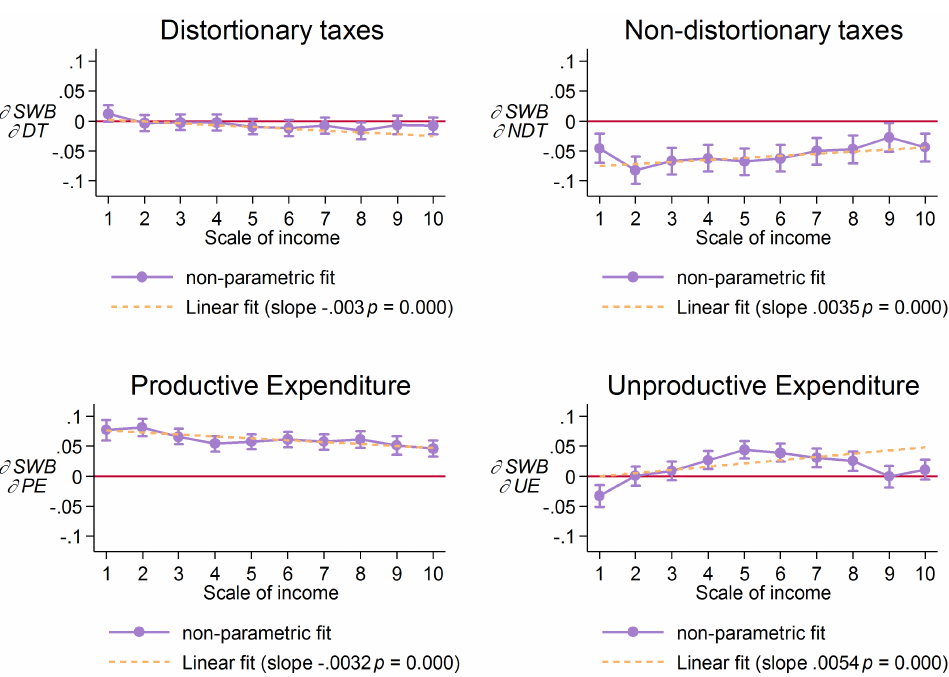
Figure 2: Marginal effects by income group (90%